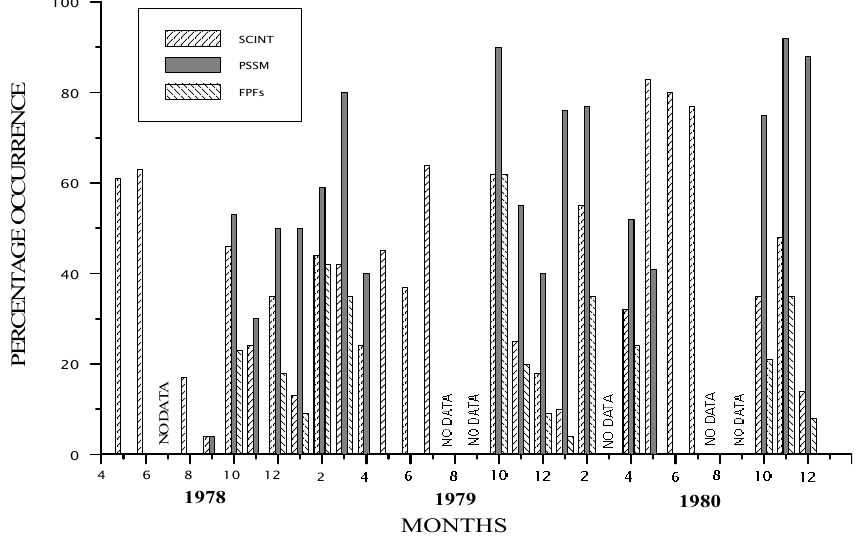
Fig. 3. Diagram showing monthly av- erage occurrence (of 1978, 1979 and 1980) of (a) PSSM, (b) scintillations and (c)